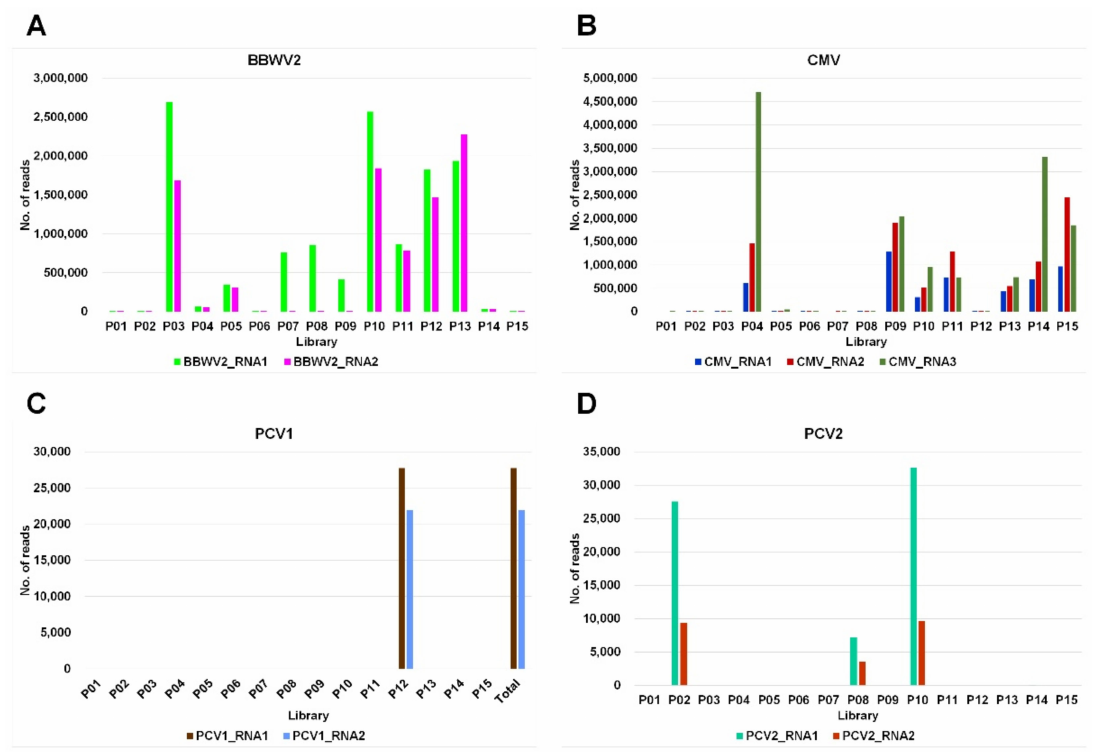
Figure 4. The number of viral reads in each library derived from four viruses composed of multiple viral segments. The number of viral reads in each library derived from BBWV2 composed of two RNA segments ( A ), CMV composed of three RNA segments ( B ), PCV1 composed of two RNA segments ( C ), and PCV2 composed of two RNA segments ( D